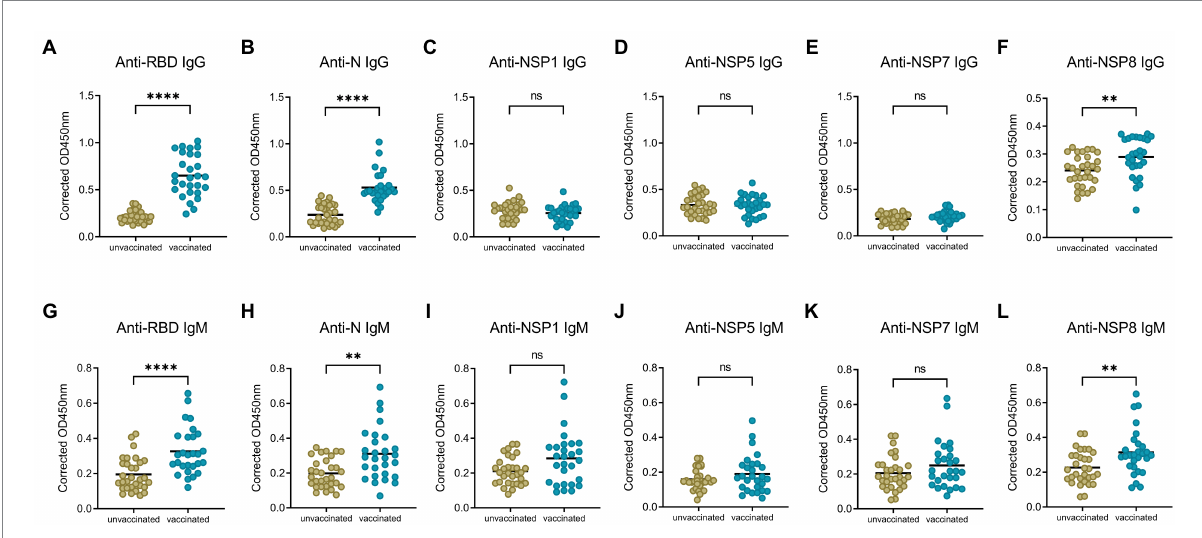
FIGURE 1 SARS-CoV-2 specific antibody responses elicited by two doses of BBIBP-CorV vaccination. (A–F) IgG responses against SARS-CoV-2 proteins, including the RBD (A) , N (B) , NSP1 (C) , NSP5 (D) , NSP7 (E) and NSP8 (F) . (G–L) IgM responses to the RBD (G) , N (H) , NSP1 (I) , NSP5 (J) , NSP7 (K) , NSP8 (L) . Serums were from the unvaccinated group ( n = 31) and the 10–30 days post the 2 nd dose group ( n = 28). Corrected OD450nm values of samples were normalized to a positive control, and background signals were subtracted. Value of p was calculated by the two-sided Student’s t -test or Mann–Whitney test. * p < 0.05, ** p < 0.01, *** p < 0.005, **** p < 0.001, ns represents not